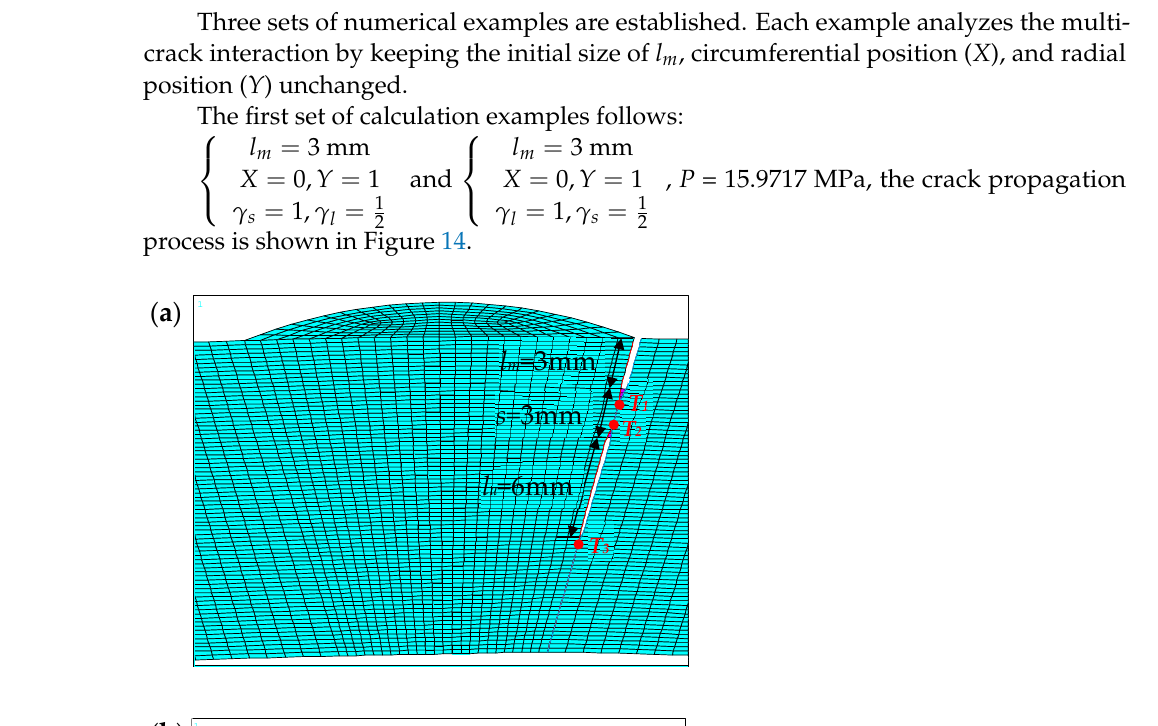
Figure 13. Schematic diagram of the X = 1/2, Y = 0 model.